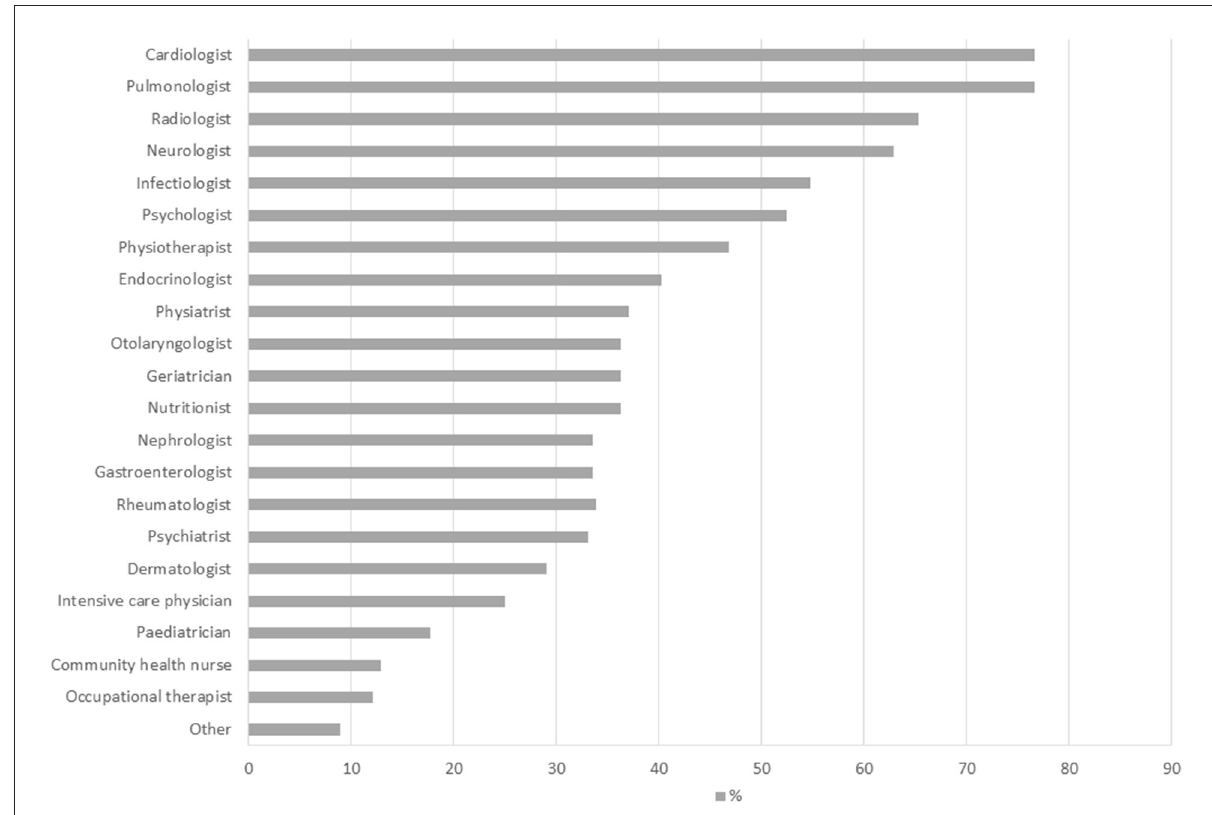
FIGURE2 Specialist support